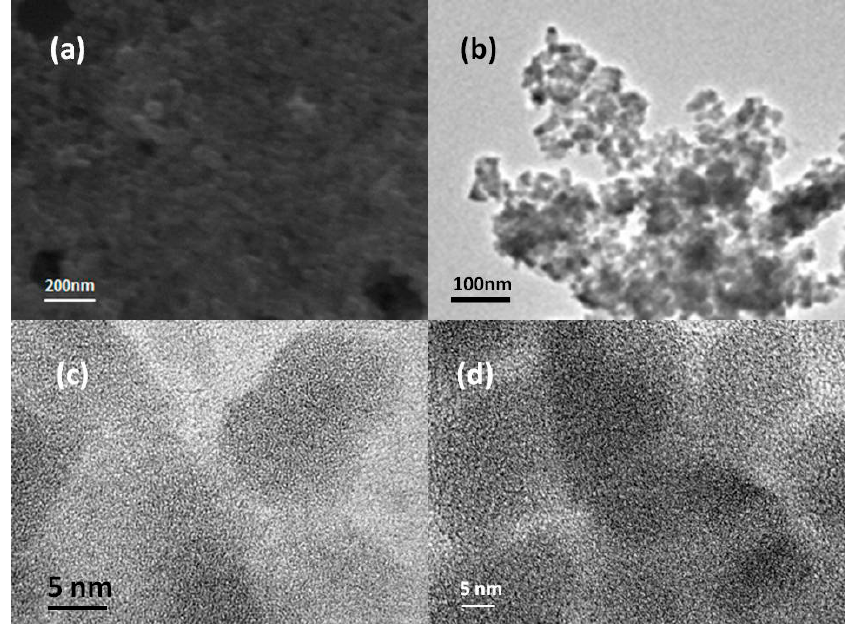
Figure 3. ( a ) Scanning electron microscopy (SEM), ( b ) transmission electron microscopy (TEM), and ( c ), ( d ) high resolution transmission electron microscopy (HR-TEM) images of the CuMo 0.7 W 0.3 O 4 (x = 0.7) photocatalyst.